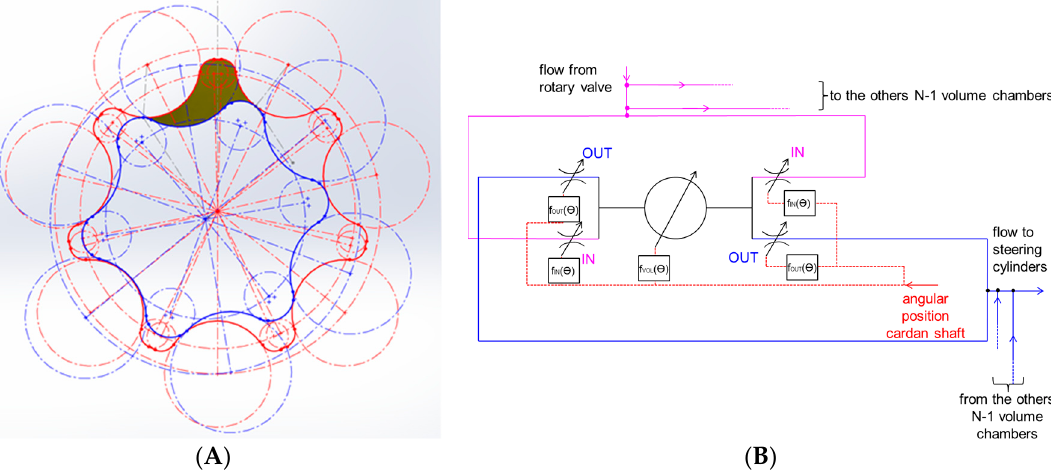
Figure 6. ( A ) One inter-teeth chamber of the orbital motor shown for two different angular position of the internal gear; ( B ) symbolic model of an inter-teeth